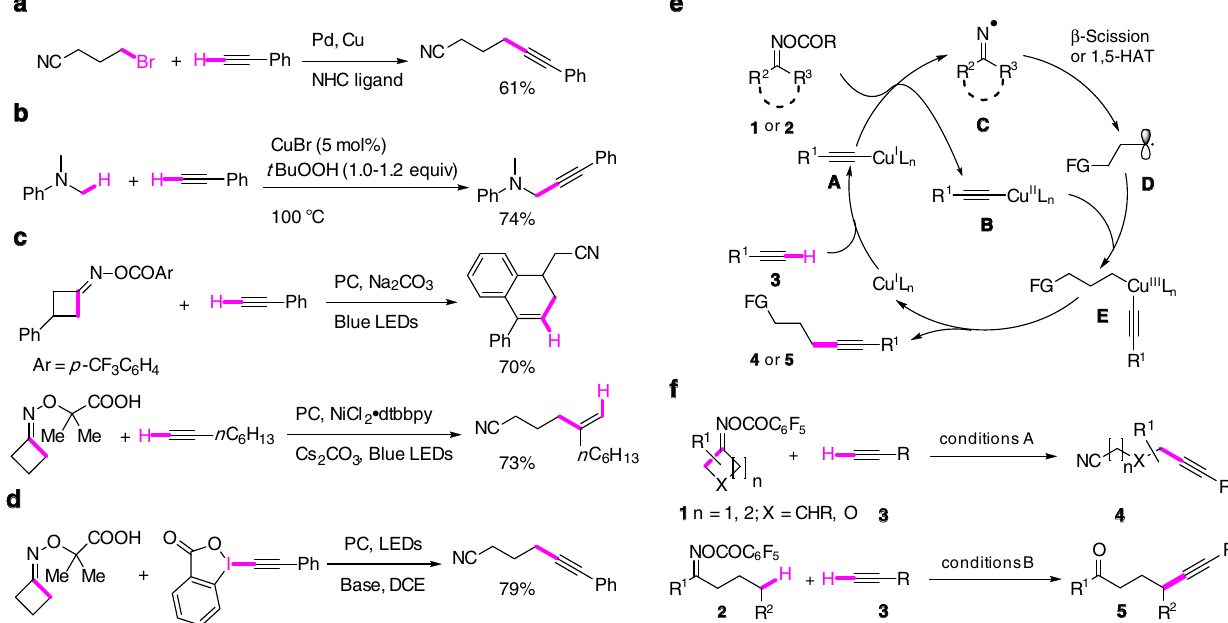
Fig. 1 Synthesis of internal alkynes. a Sonogashira coupling of unactivated alkyl halides with terminal alkynes (Fu 3 ); b Cu-catalyzed alkynylation of C(sp 3 )- H adjacent to a nitrogen atom (Li 7 ); c terminal alkynes as radical acceptors (Chen and Xiao 19 , Leonori 28 ); d alkynylation of C-radicals with Waser ’ s EBX reagent 25 ; e reaction design: working hypothesis; f Cu-catalyzed C(sp 3 ) – C(sp) coupling of oxime esters with terminal alkynes. NHC N -heterocyclic carbene, dtbbp 4,4 ′ -di- tert -butyl-2,2 ′